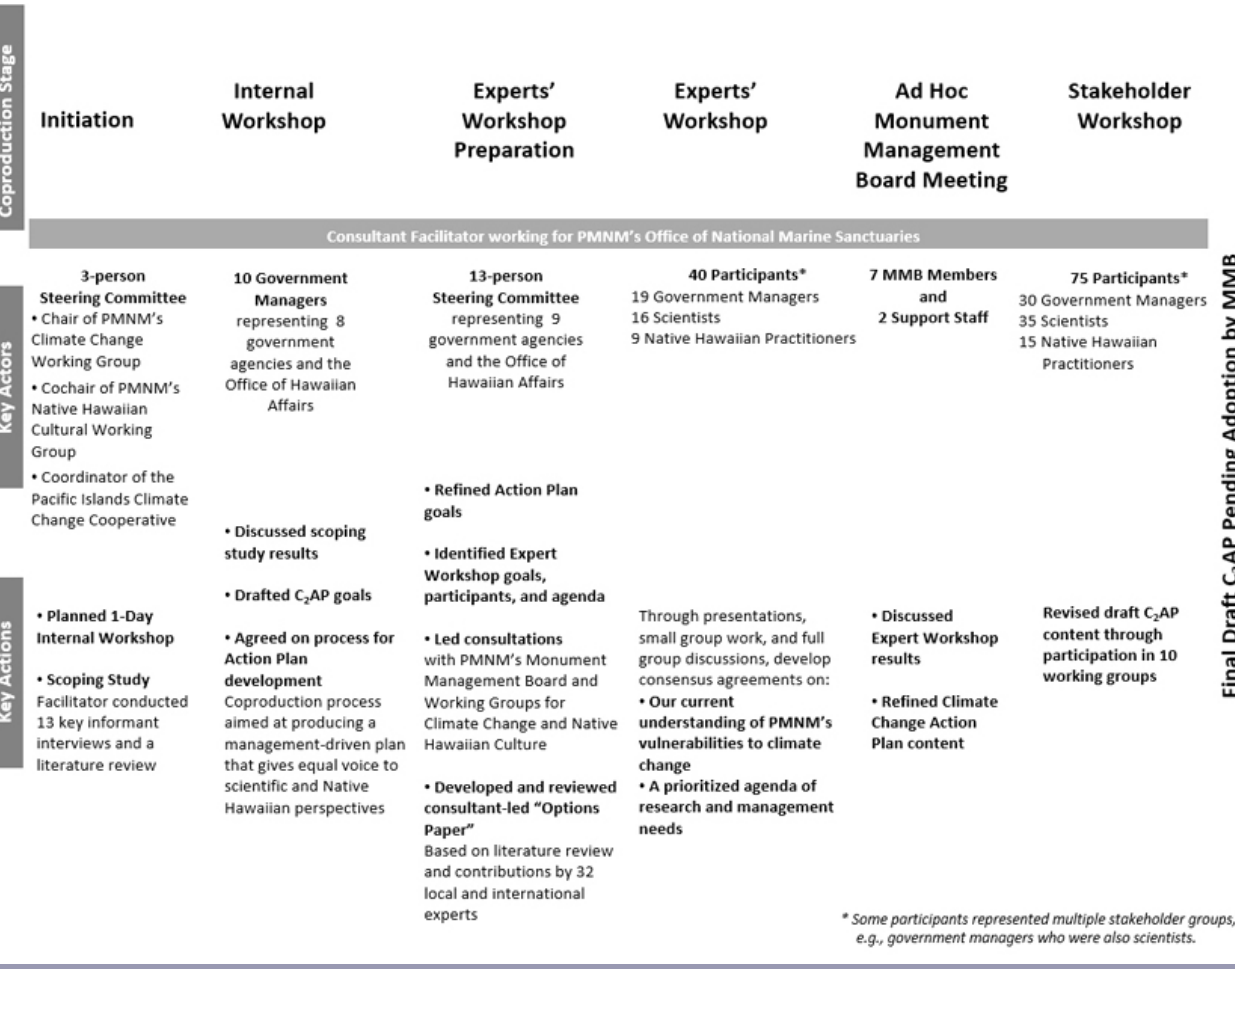
Fig. 2 . The coproduction process for developing Papah ā naumoku ā kea Marine National Monument’s (PMNM) Climate Change Action